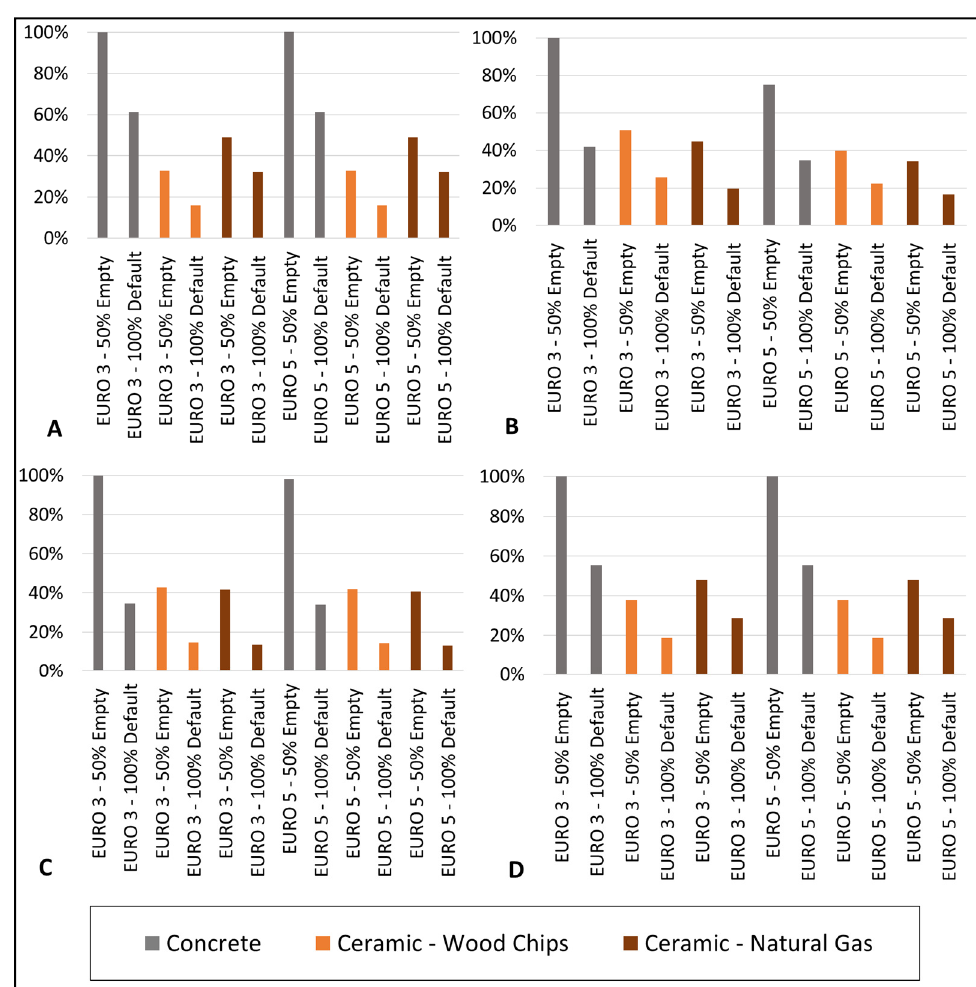
Figure 14. Results for the impact categories when considering the housing deficit for different sensitivity analysis scenarios. The results were normalized with the concrete blocks—EURO 3—50% empty scenario. ( A ) Climate Change; ( B ) Human Health; ( C ) Ecosystem Quality; ( D ) Resources depletion; 100% Default—represents that the truck is loaded with 100% of its capacity and returns full; 50% Empty—represents that the truck is loaded with 50% of its capacity and returns empty.